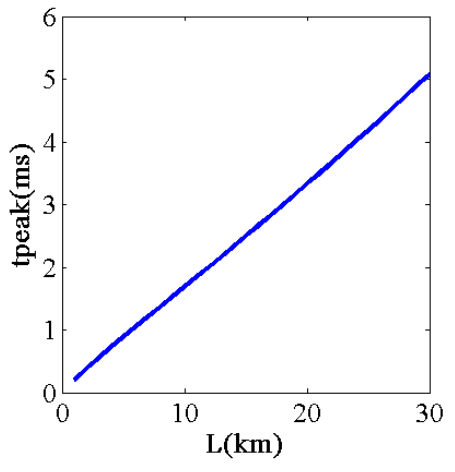
Figure 10. The time that the current takes to reach the peak versus the fault position.